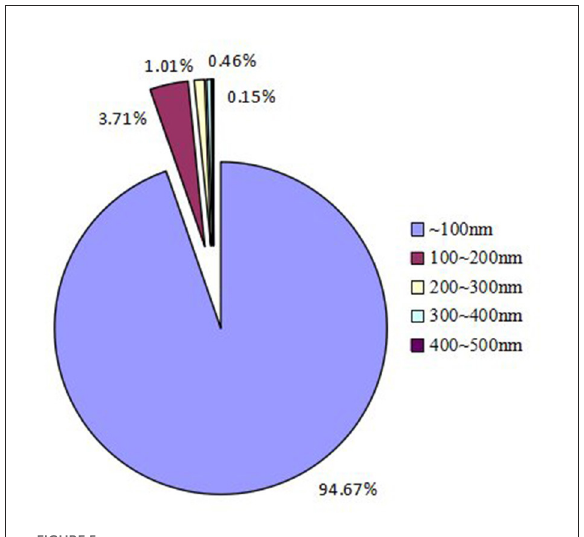
FIGURE5 Percentages of particle number distribution with different particle size at lunch